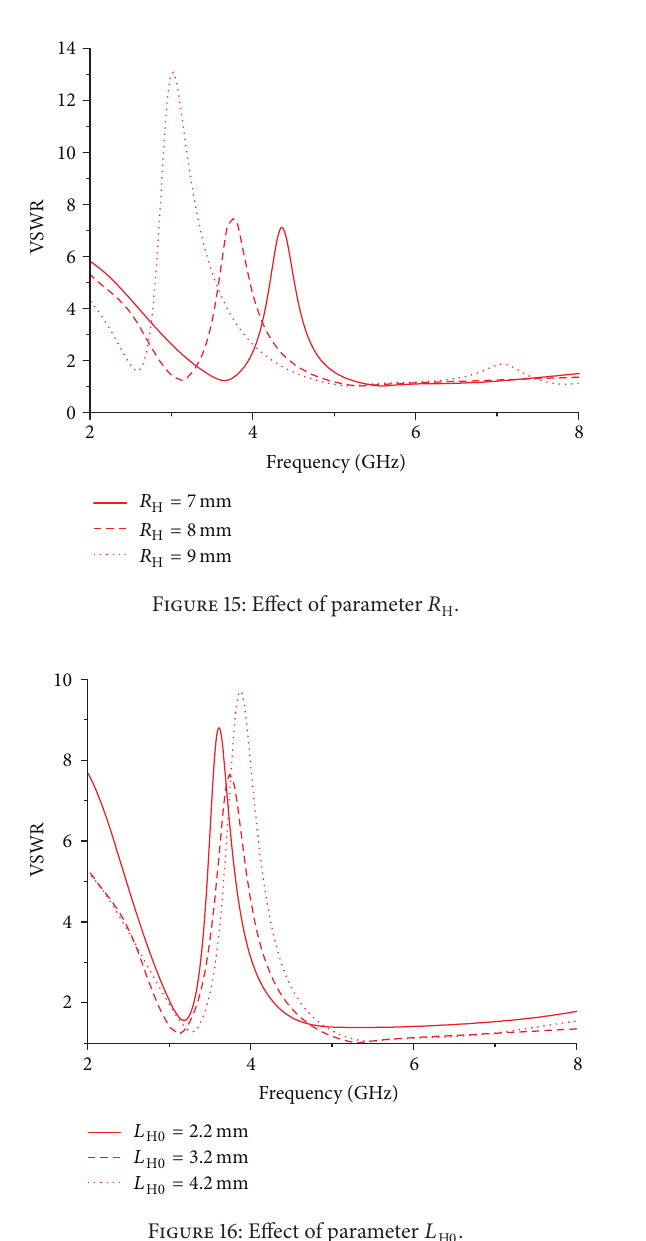
Figure 16: Effect of parameter 𝐿